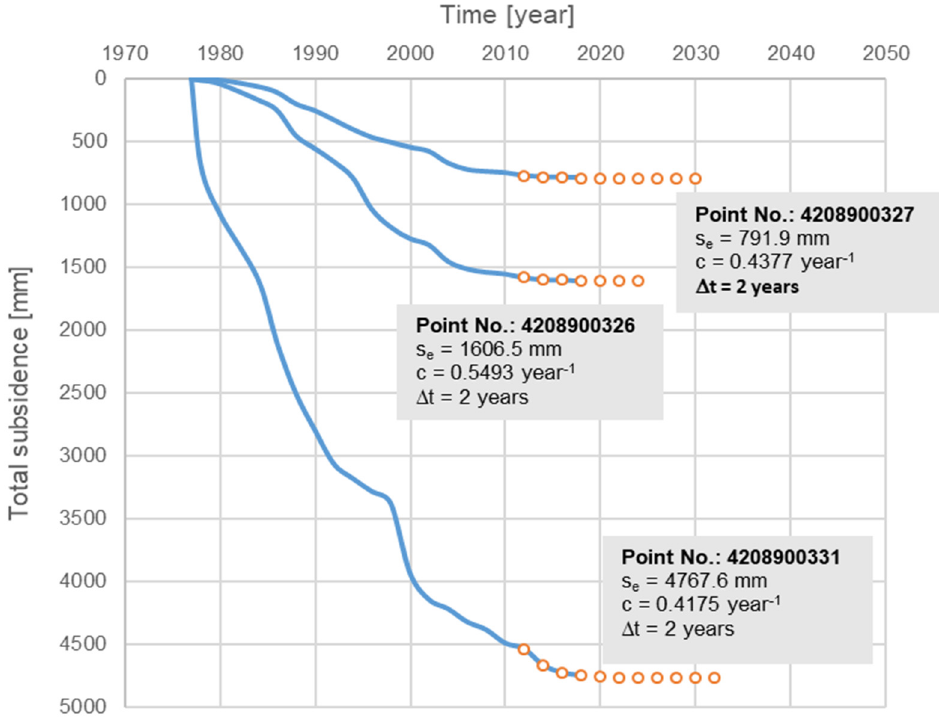
Figure 9. Results of calculations of total subsidence for measurement points 4208900326, 4208900327, and 4208900331 (blue line—measured subsidence; orange markers—predicted residual subsidence). Additionally, Table 7 presents the estimated subsidence time t e ( ∆ s Gr ) for the individ- ual measuring points, which depends on the defined residual subsidence limit ∆ s Gr